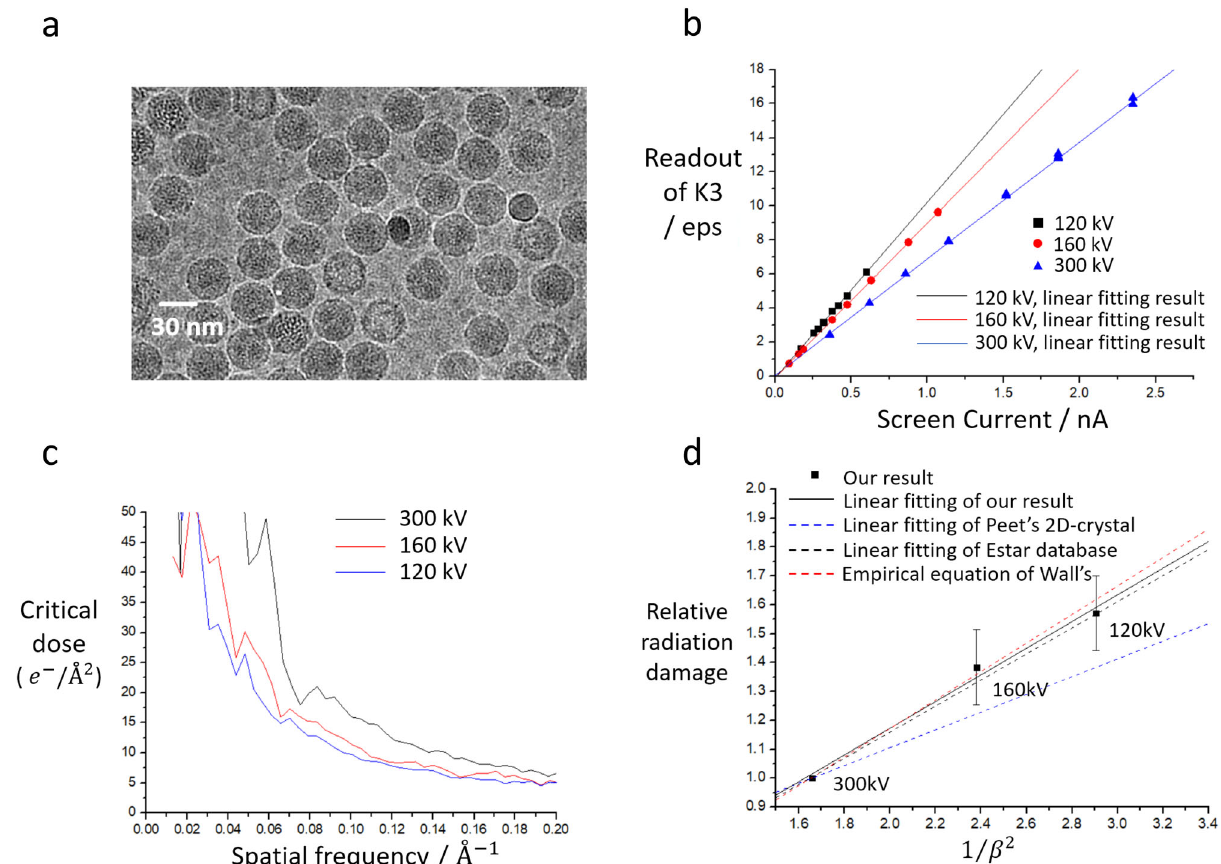
Fig. 1 Measuring radiation damage in vitri fi ed protein. a Sample image of Coxsackievirus A10. Image was taken at 120 kV with defocus of − 1.0 μ m. Sigma-contrast of image was set to three and low-passed to 20 Å. b Comparison of raw-readouts of K3 camera to screen current at 300/160/120 kV. The K3 operated on non-CDS mode and magni fi cation of 22,500x. c The critical doses of Coxsackievirus A10 at 300/160/120 kV. The critical doses were calibrated by ‘ counting scaling factor ’ and rescaled to fi t Grant ’ s results at 300 kV. d Comparison of critical doses of vitri fi ed protein samples to 2D-crystal samples. The relative radiation damage uses critical dose of 300 kV as a reference and obtained by averaging the results in frequency between 10 Å to 5 Å of Fig. 1c. Error bars represent 1 standard deviation. β represents the ratio between electron velocity and speed of light. The linear fi tting result is y ¼ 0 : 24832 þ 0 : 46211 = β 2 ., with R-square = 0.97823. The ‘ Empirical equation ’ line was a linear fi tting result from function of Wall ’ s 32 . The ‘ Estar database ’ line was the linear fi tting result of stopping-power of carbon from Estar database 16